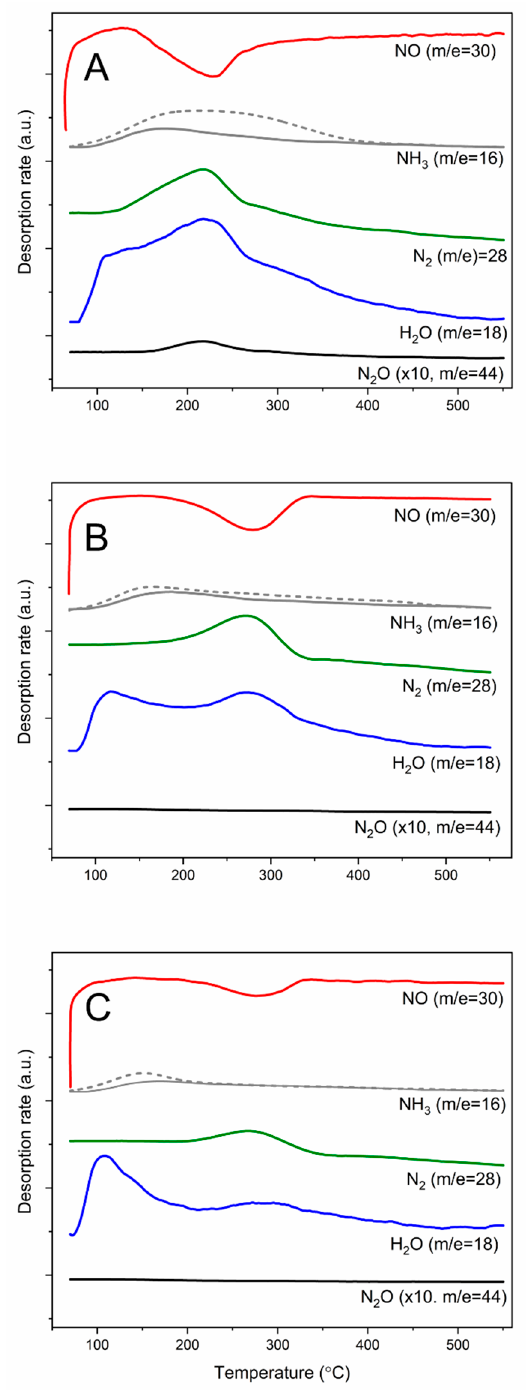
Figure 11. Results of NH 3 -SCR temperature-programmed surface reaction for 25Cu-MCM-41 ( A ), 20Fe-MCM-41 ( B ), and 100Fe-MCM-41 ( C ).